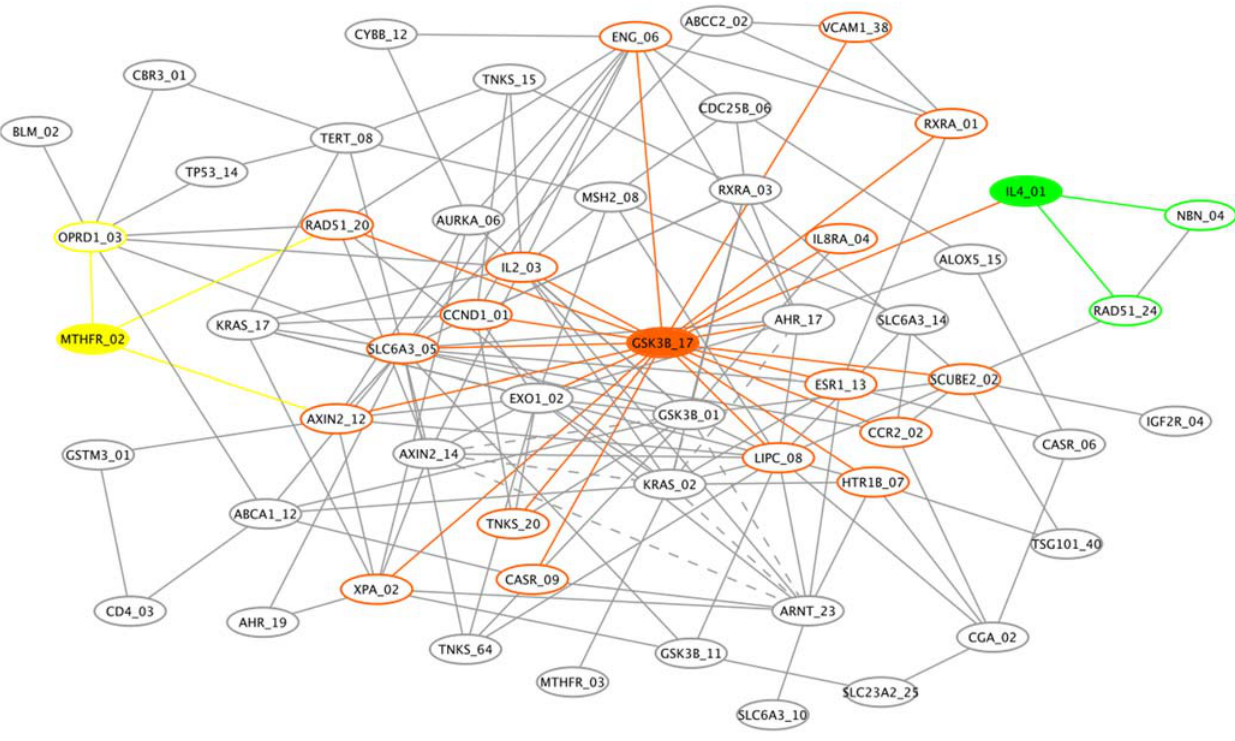
Figure 4. Genetic association interaction network (GAIN) for the top 70 SNPs selected by Evaporative Cooling (EC) as most relevant to smallpox vaccine-associated adverse events. Three nodes and their connections are highlighted: the hub glycogen synthase kinase 3 beta (GSK3B, orange) and the two main effect genes, 5,10-methylenetetrahydrofolate reductase (MTHFR, yellow) and interleukin-4 (IL4, green). Solid edges indicate synergy (positive interaction information (II)) between incident SNPs that results in an increase in information about the phenotype when the two SNPs are considered jointly. Dashed edges between incident SNPs indicate redundancy (negative II) with respect to information about the